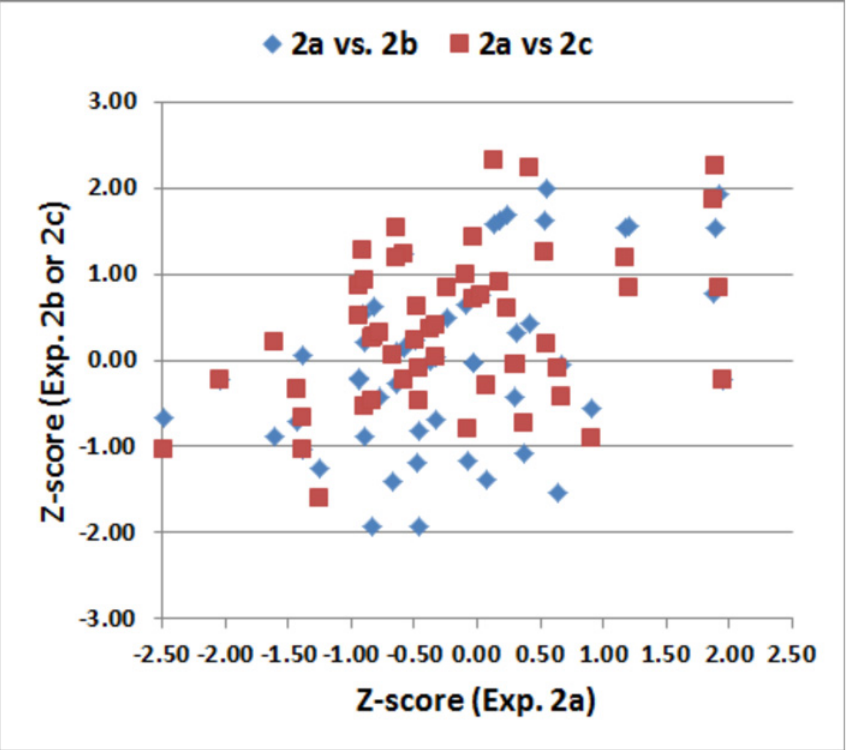
Fig 6. Test-retest reliability. Z-scores from each subject in Experiment 2a are shown plotted against z- scores from Experiment 2b (blue diamonds) and Experiment 2c (red squares). Pearson correlations were 0.53 between 2a and 2b, 0.48 between 2a and 2c, and 0.66 between 2b and 2c. The overall intraclass correlation coefficient was